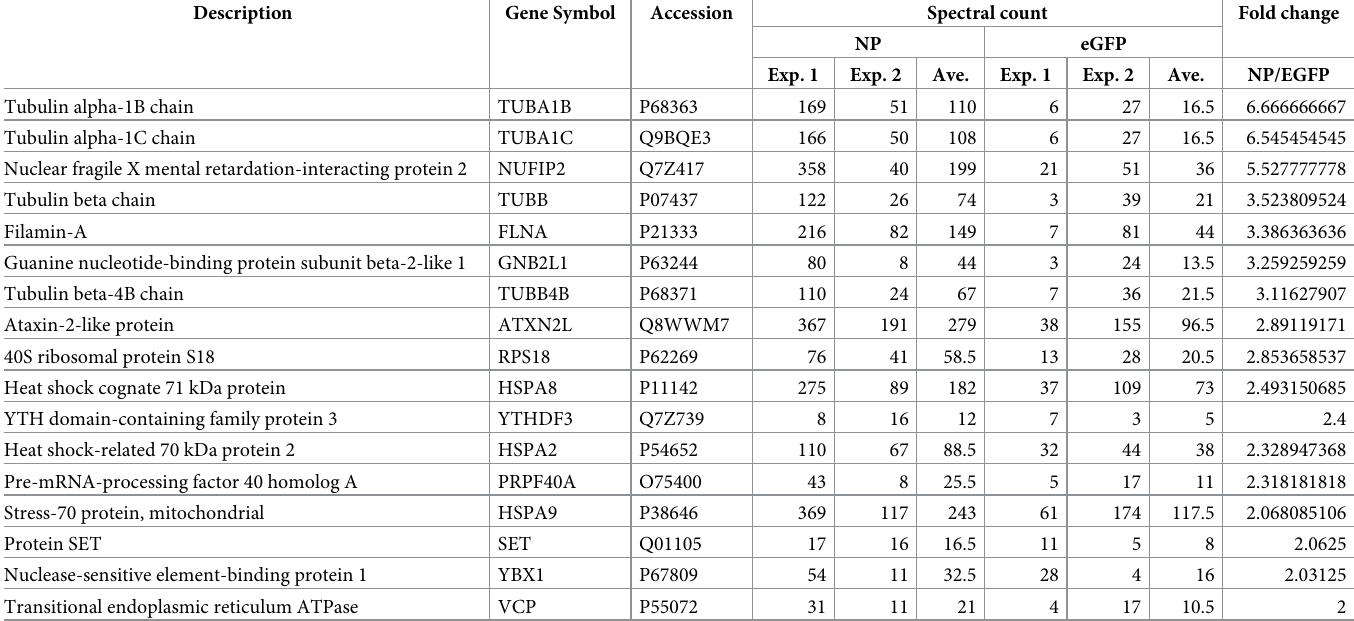
Table 2. Identified host-cell proteins with spectral counts at least 2-fold higher in NP pull down samples than eGFP